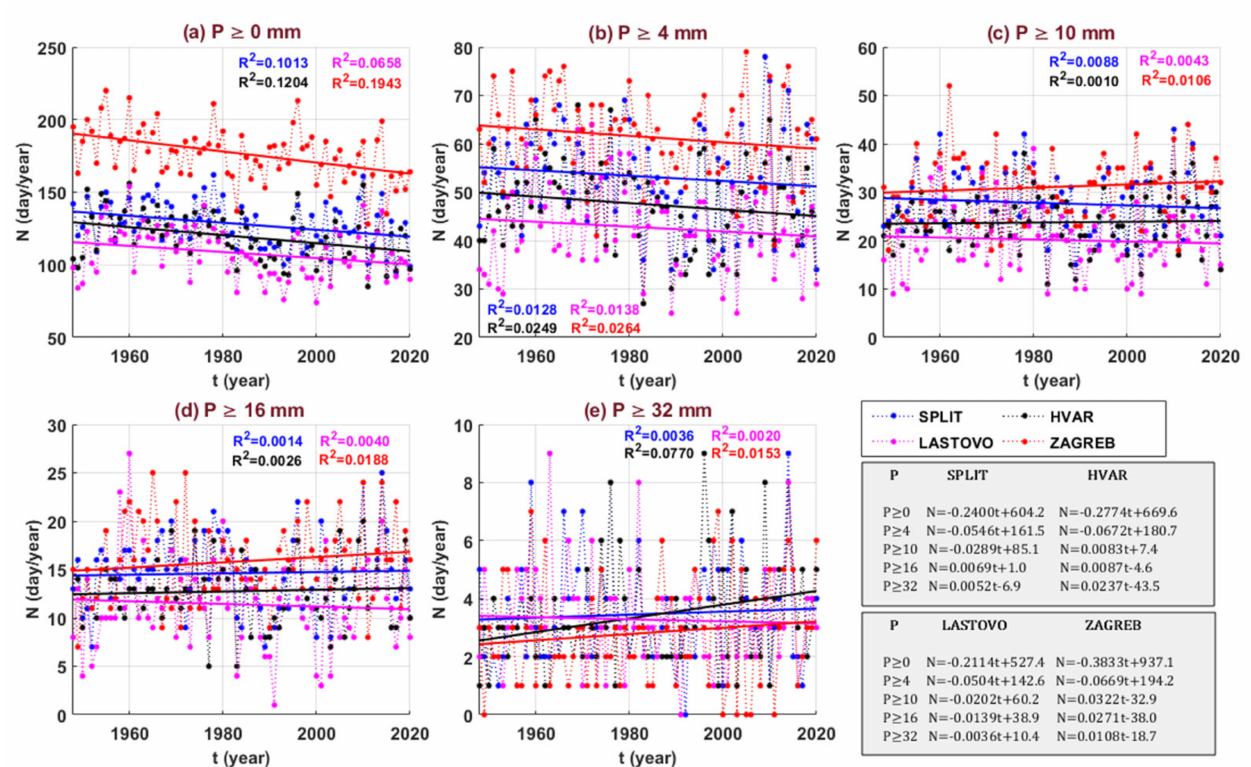
Figure 5. Time series of the number of days in a year, N, with precipitation, P ≥ 0.0 mm ( a ), P ≥ 4.0 mm ( b ), P ≥ 10.0 mm ( c ), P ≥ 16.0 mm ( d ) and P ≥ 32.0 mm ( e